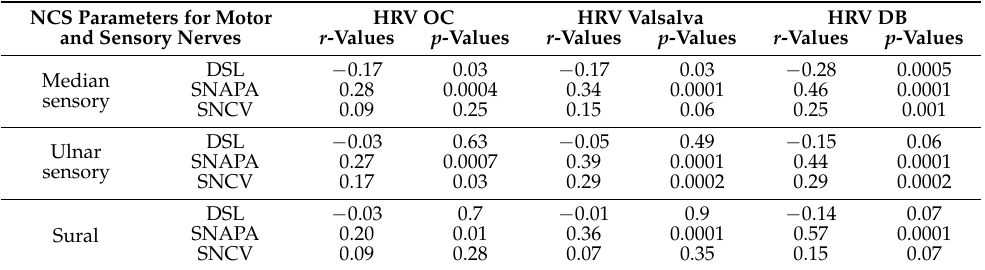
Table 4. Results of correlations between electrophysiological parameters of sensory nerve function and HRV tests.